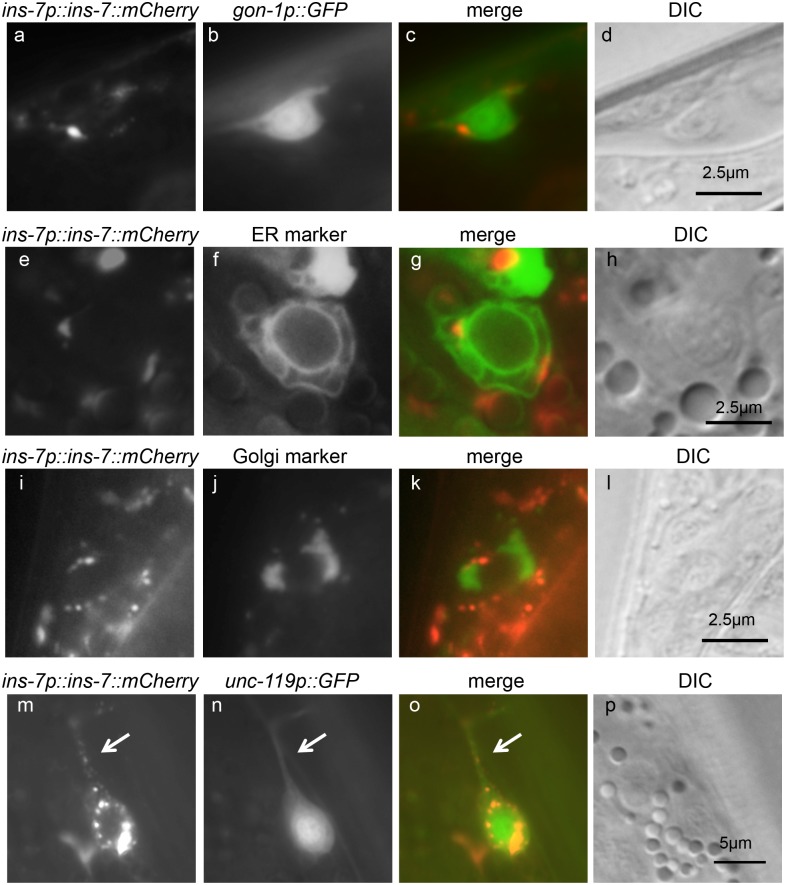
INS-7 accumulates in the ER and secretory vesicles in neurons in gon-1 mutants.(a, b) Representative fluorescent images of a gon-1(tm3146) mutant animal expressing INS-7::mCherry (a) and gon-1p::GFP (b). (c) The merged image of (a) and (b). (d) The DIC image of the same field shown in (a-c). (e, f) Representative fluorescent images of mCherry-tagged INS-7 (e) and an ER marker (f) in a gon-1 mutant animal. (g) The merged image. (h) The DIC image of the same field shown in (e-g). (i, j) Distribution patterns of mCherry-tagged INS-7 (i) and a Golgi marker (j) in a gon-1 mutant animal. (k) The merged image. (l) The DIC image of the same field shown in (i-k). Scale bars indicate 2.5 μm. (m, n) Distribution patterns of mCherry-tagged INS-7 (m) and unc-119p::GFP (n) in a gon-1 mutant animal. (o) The merged image. (p) The DIC image of the same field shown in (m-o). The arrow indicates an axon in which INS-7::mCherry is accumulated. The scale bar indicates 5 μm.